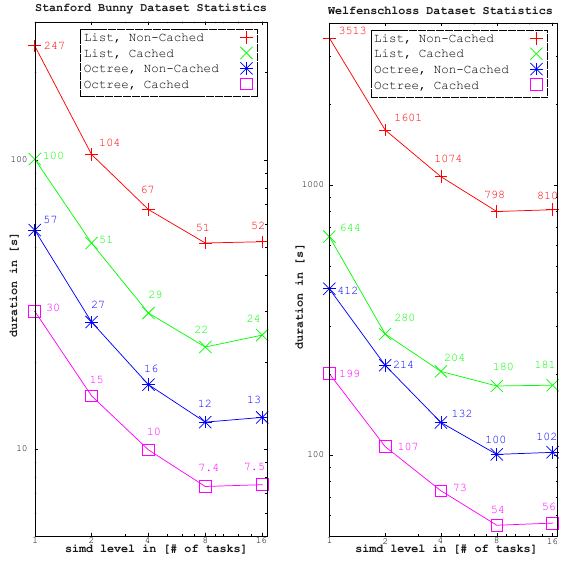
Figure 6: Duration